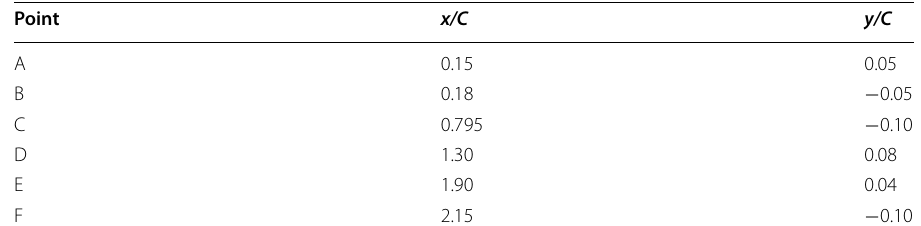
Table 2 Coordinates of the points marked in Fig. 13b